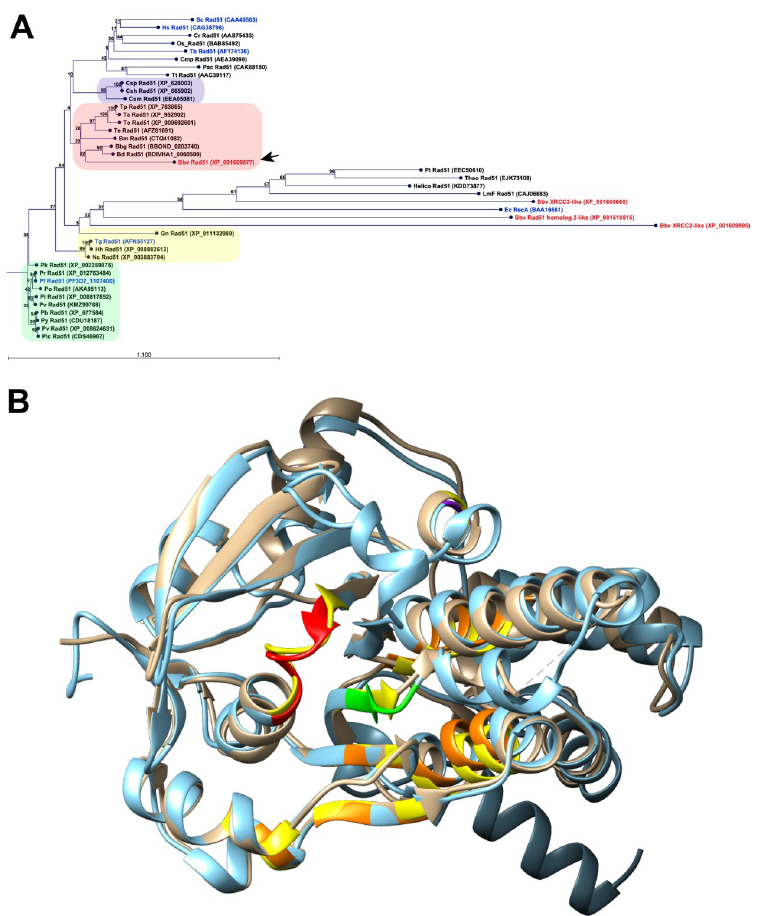
Fig 1. Relationship of BbRad51 to other Rad51 proteins. A. Alignment tree of the four B . bovis RecA/RadA/ Rad51-related proteins (accession numbers in red) with established or predicted Rad51 proteins of other species (Neighbor-joining; Kimura protein distance measure; 100 bootstrap replicates; numbers at nodes are bootstrap values). Direct experimental evidence supports the catalysis of canonical RecA/RadA/Rad51 activities by those proteins whose accession number is indicated in blue. BbRad51 (black arrow) clusters with, but is comparatively dissimilar to, putative Rad51 proteins of other Piroplasmida (pink panel). In contrast, the three remaining B . bovis proteins cluster more closely with the prokaryotic ( E . coli ) RecA protein included as outlier to the alignment, and with several algal Rad51 proteins. All four B . bovis proteins cluster away from other apicomplexan parasites (Haemosporida, green panel; Coccidia, yellow panel) or higher eukaryotes. Interestingly, Cryptosporidium spp . cluster separately from other Coccidia (blue panel). B. The predicted three-dimensional structure of BbRad51 (blue ribbon), superimposed upon the crystal structure of the S . cerevisiae Rad51 H352Y mutant (3LDA [30], tan ribbon), shows excellent conformational coherence. Indicated on BbRad51 are the Walker A (red) and Walker B (green) motifs, subunit interaction domains (orange), and the position of residue Q298 that acts as “gatekeeper” controlling access of ATP to the active site (purple). Corresponding ScRad51 residues are shown in yellow. ScRad51 has a disordered N-terminal extension that fails to yield usable crystal data [19], resulting in a lack of sequence to align with that region of BbRad51. For brevity, CE11 Δ rad51 ko1 H5 is hereafter referred to as “ ko1 H5”. The structure of the modi- fied Bb rad51 locus and loss or gain of Bb rad51 or gfp-bsd transcription, respectively, was con- firmed by diagnostic PCR, RT-PCR, and Southern blotting, confirming the replacement of Bb rad51 with the gfp-bsd selection cassette from pRad51KO (Fig 2B; S2 and S3 Figs). PCR- crossover homologous recombination (HR) had occurred. Two additional independent knockout clonal lines, CE11 Δ rad51 ko2 and CE11 Δ rad51 ko3 (for brevity, referred to as “ko2”